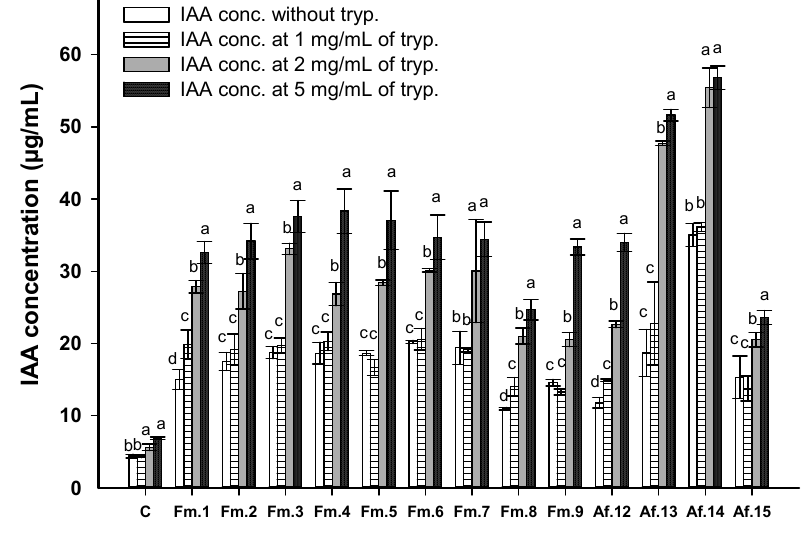
1 C: controls without bacterial inoculation. Identity of the bacterial isolates is available in Table 2. 2 -, + , and ++ denote no, low, and high ammonia production, respectively. 3 Di ff erent letters between columns denote that mean values are significantly di ff erent ( p ≤ 0.05) by Tukey’s test, means ± SE ( n = 3).